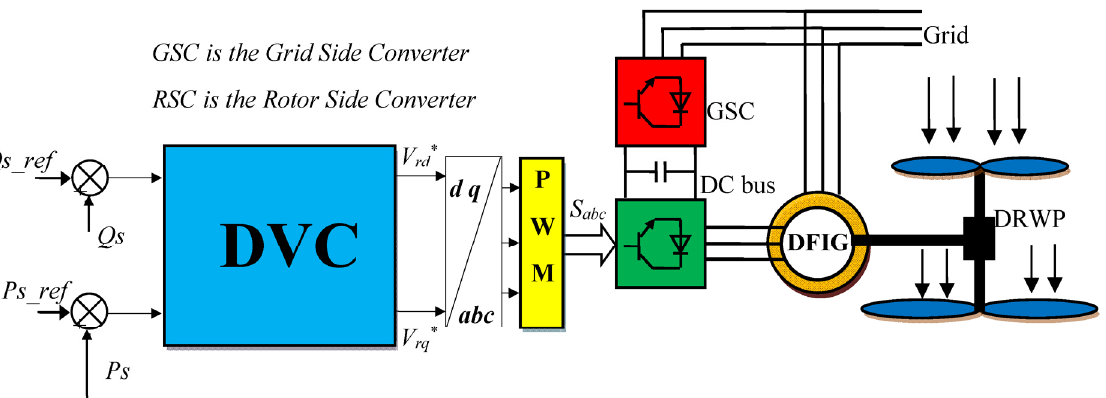
Figure 9. DVC method of three-phase DFIG-based DRWP system.